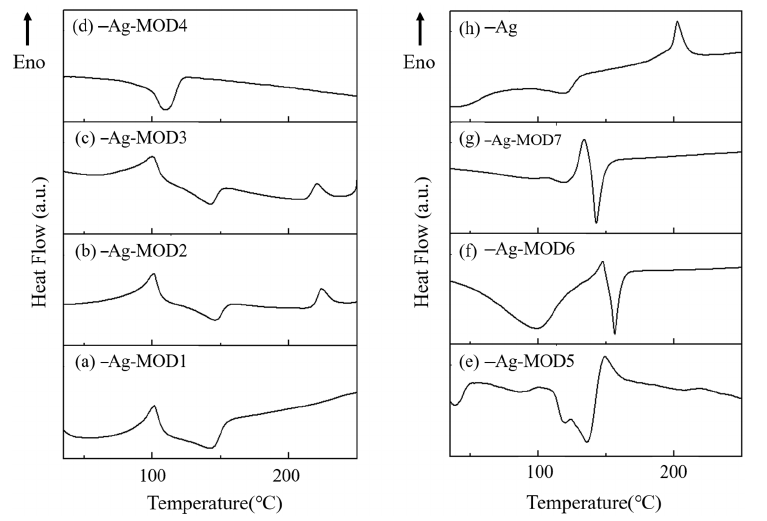
Figure 8. DSC curves of different Ag composite pastes (Arrow direction represents endothermic reaction): ( a ) Ag/MOD1, ( b ) Ag/MOD2, ( c ) Ag/MOD3, ( d ) Ag/MOD4, ( e ) Ag/MOD5, ( f ) Ag/MOD6, ( g ) Ag/MOD7, ( h ) Ag.